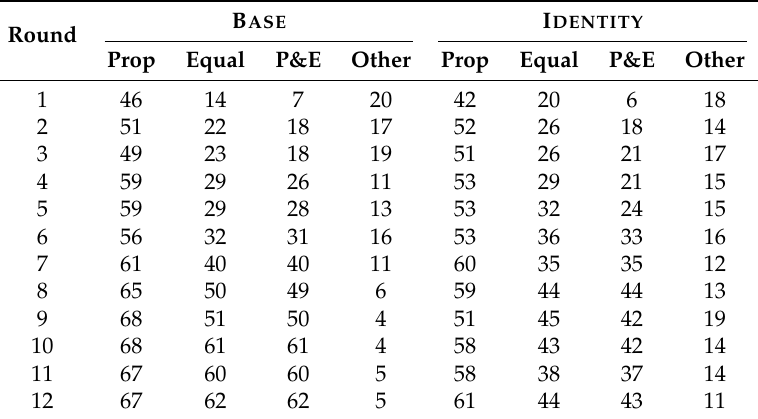
Table 1. Allocation Decisions by